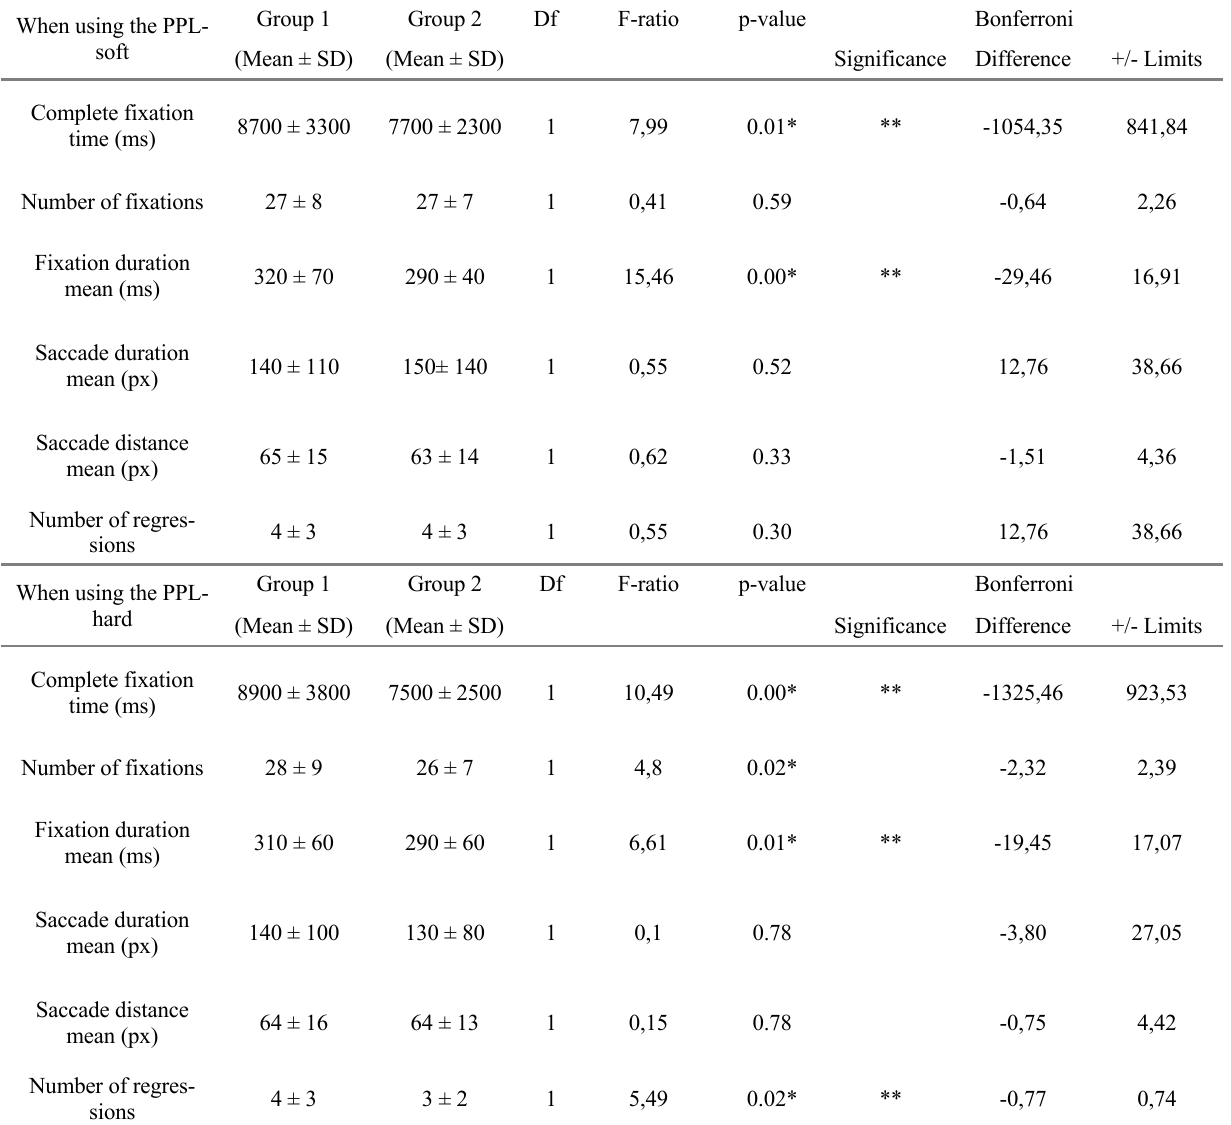
Table 3. EM differences according to the user’s PPL preference when participants were using PPL-soft and PPL-hard. Statistical significance p<0.05, randomized complete block test